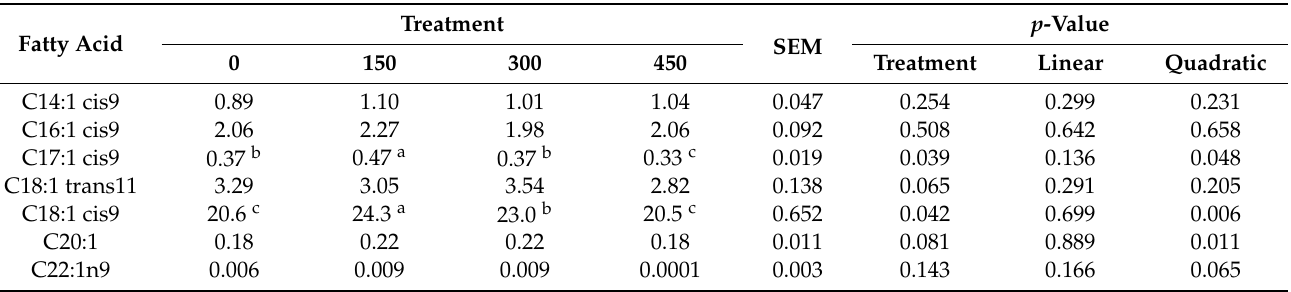
Table 2. Monounsaturated fatty acids (g/100 g of total fatty acids) in milk from crossbred F1 dairy cows fed on tropical grasses and supplemented with different levels of concentrate (0, 150, 300 and 450 g of DM concentrate/kg of daily milk